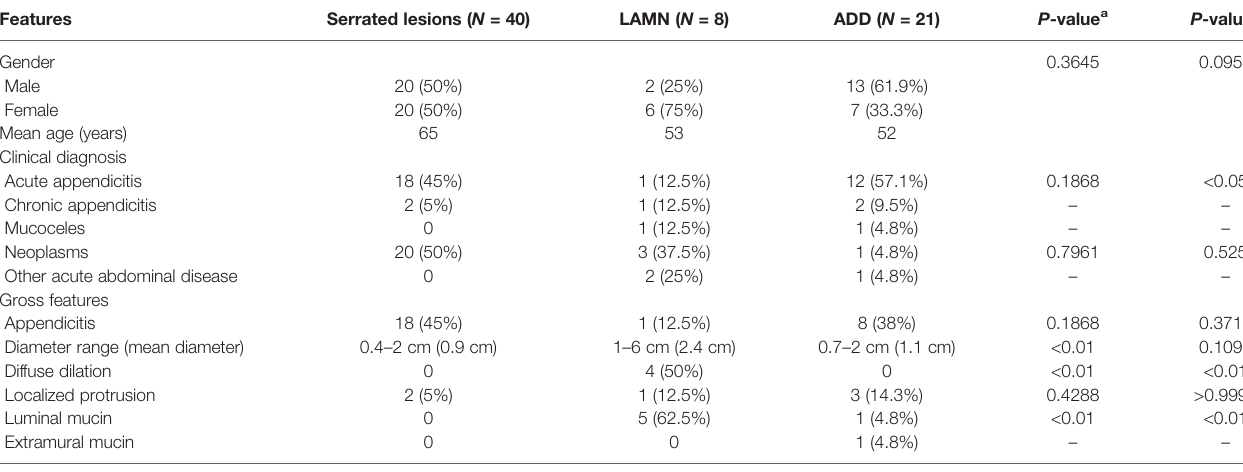
TABLE 2 | Clinical and gross features among patients with appendiceal serrated lesions, LAMN, and ADD. Features